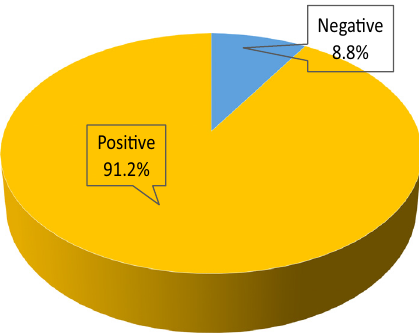
Figure 2: Chart showing % EIA applications concluded as positive and negative [ 16 ] .